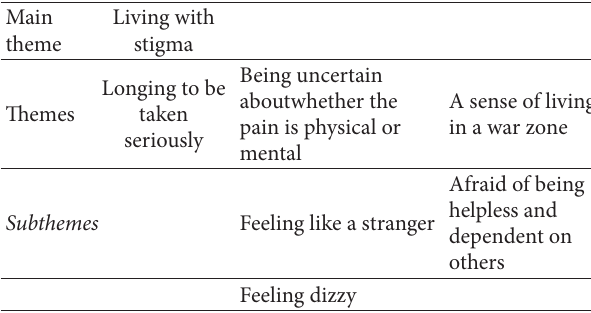
Table 2: Living with stigma: depressed elderly persons’ experiences of physical health problems and